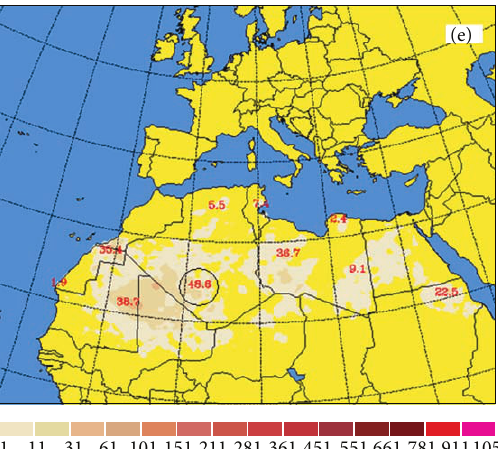
Figure 5: Dry deposition on 3 March 2004 at 12 UTC, (a) total dry deposition, (b) clay particle, (c) small silt particle, (d) large silt particle, and (e) sand